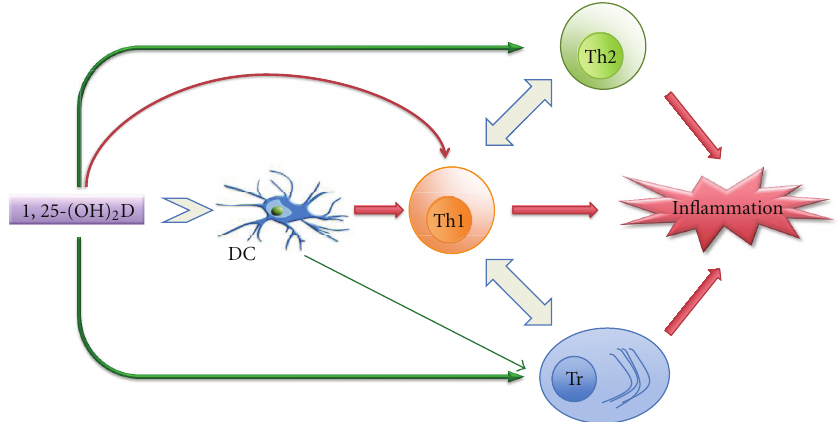
Figure 1: The in vitro e ff ects of 1,25(OH) 2 D on the immune system. The e ff ects of 1,25(OH) by arrows. While a green arrow represents positive influence, a red arrow represents the negative influence. The negative influence on inflammation indicates dampening of the inflammatory response. DC: dendritic cell, Th1: T helper type 1 lymphocyte, Th2: T helper type 2 lymphocyte, Tr: regulatory T lymphocyte